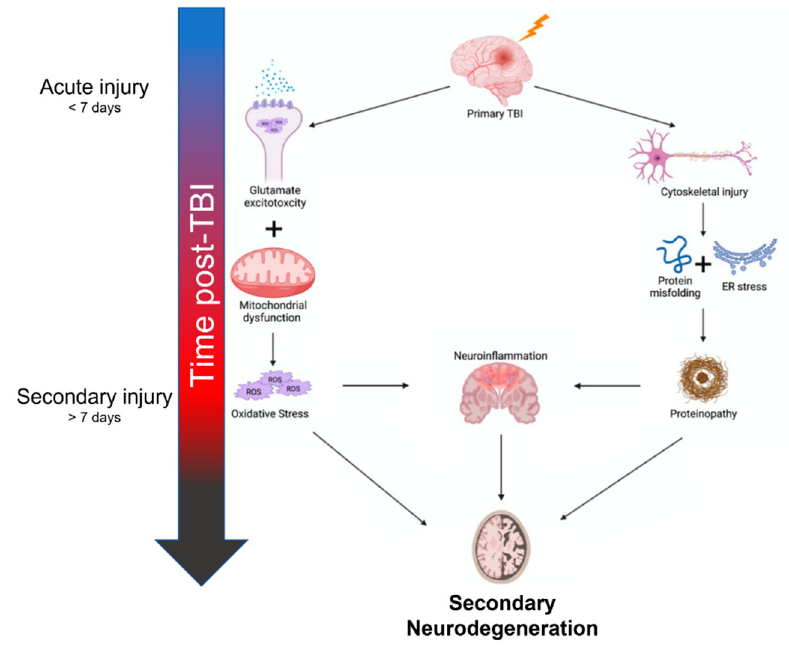
Figure 1. Summary of mechanisms contributing to secondary neurodegeneration following traumatic brain injury.